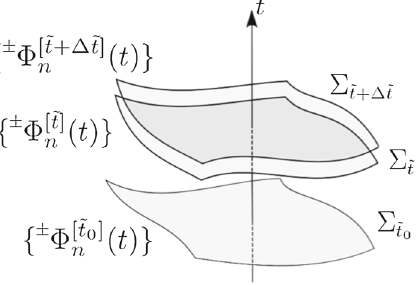
[˜ t ] ( t ) } to Cauchy hypersur- n